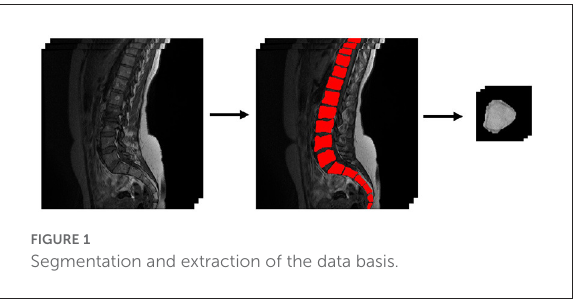
FIGURE1 Segmentation and extraction of the data basis.